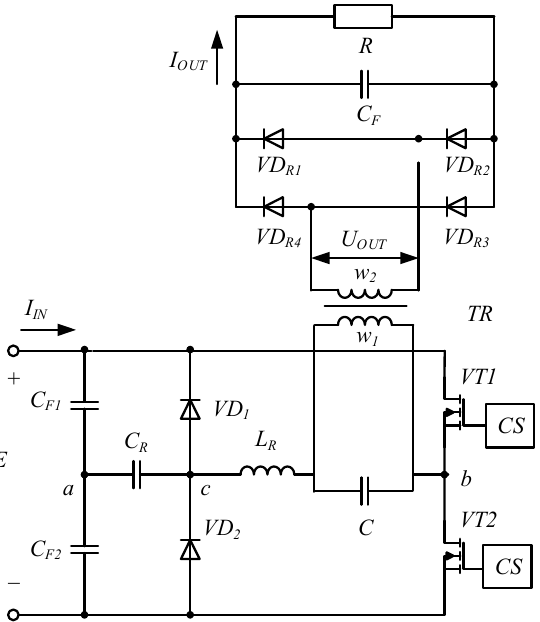
Figure 1. Half-bridge DC–DC converter with energy dosing. Of the possible operating modes, the most suitable when using the circuit is the mode when the operating frequency is less than the resonant frequency of the alternating current (AC) circuit of RI with ED, i.e., f < f 0 . Figure 2 shows the time diagrams of the current through the resonant inductor L R , the voltage of the resonant capacitor C R , the output current and the voltage of the transistor VT 1 , which clarifies the principle of operation. It should be noted that the transistors operate with zero on and off current (ZCS).